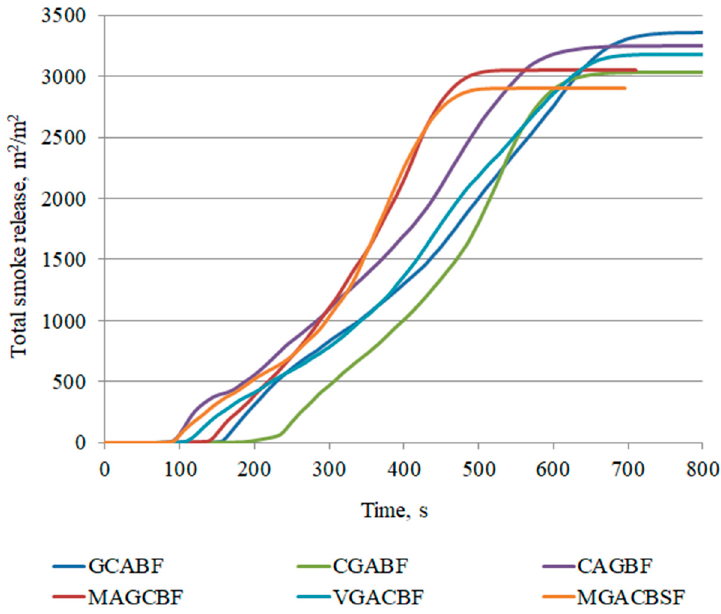
Figure 12. Representative curves of total smoke release of the EP ‐ based composites.